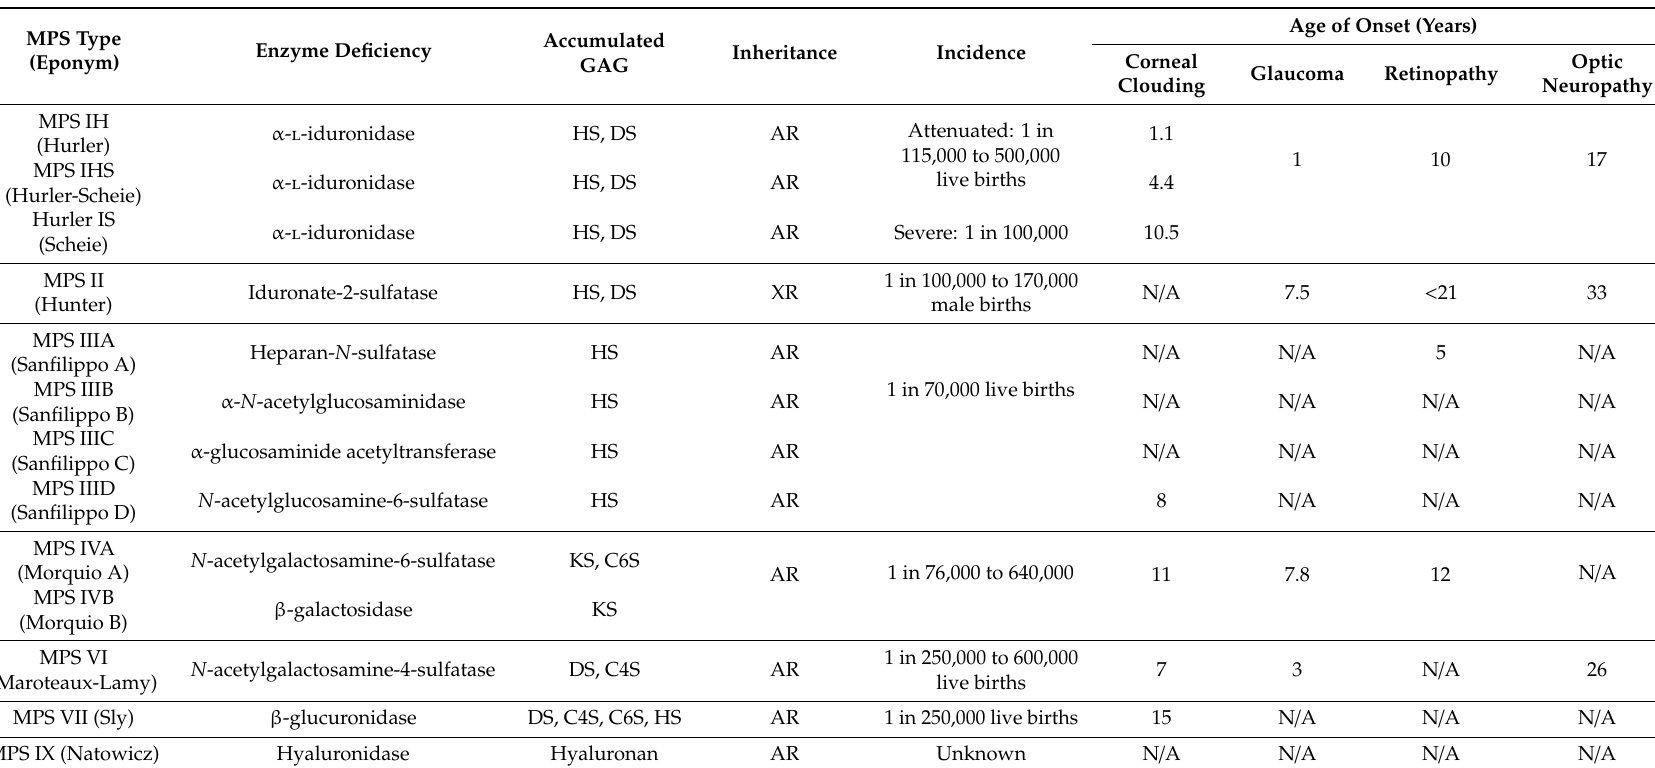
Table 1. Age of onset of ocular diseases in mucopolysaccharidosis (MPS). The ages presented in the table are earliest manifestations of ocular pathology reported in the literature on extensive case reviews. No meta-analysis was available aside from corneal clouding in MPS I. This table should only be used as a reference and not as a definitive